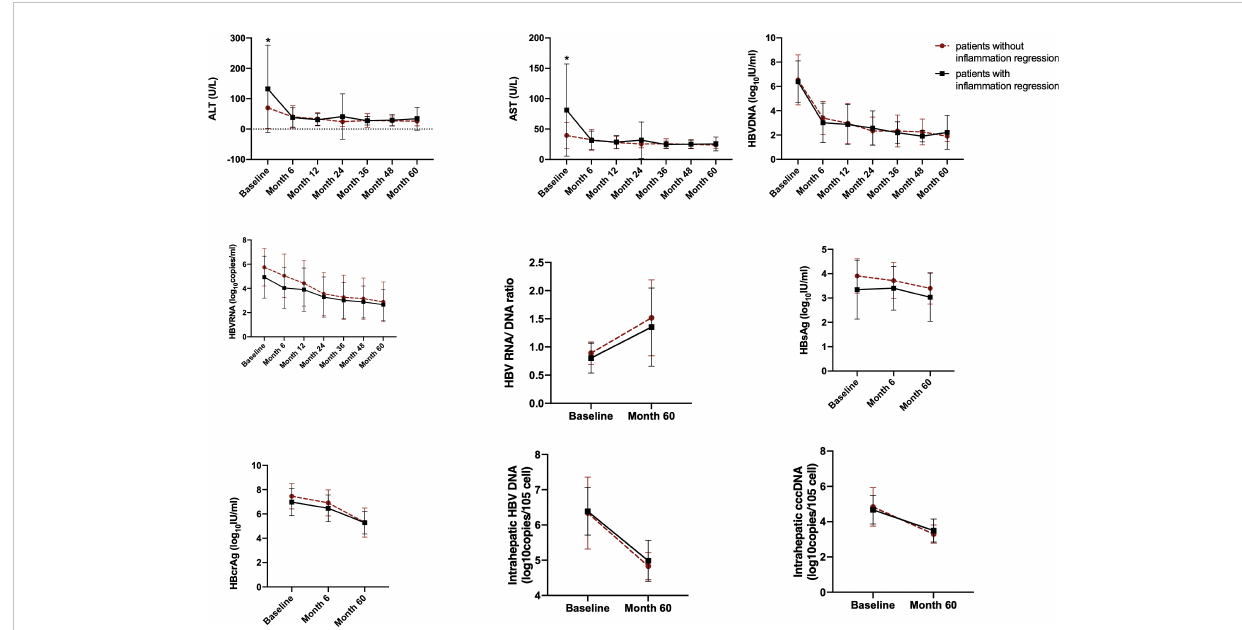
FIGURE 4 The dynamic changes of HBV markers, ALT and AST in HBeAg-positive CHB patients during NAs treatment. Variables are expressed as means and standard deviations. HBsAg, hepatitis B surface antigen; HBcrAg, hepatitis B core-related antigen; cccDNA, covalently closed circular DNA. *Signi fi cant difference between patients with in fl ammation regression and patients without in fl ammation